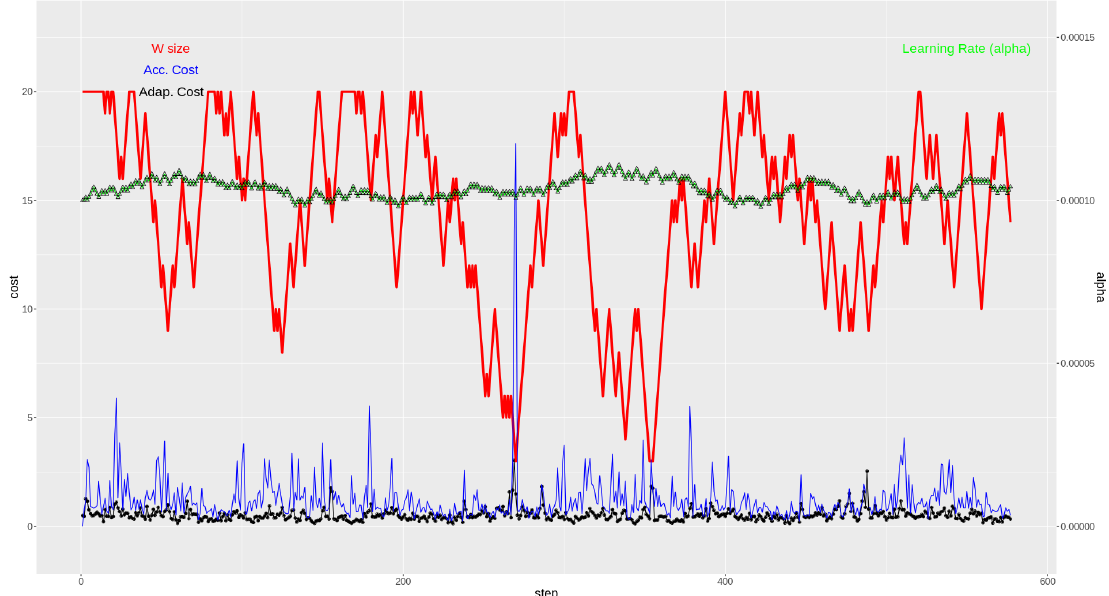
Figure 8. Weather station ID C457I: Worst performance case for the adaptive method. In the lower part, cost (MSE, (m/s) 2 ) obtained with the adaptive strategy (black) and with the accumulative strategy (blue). In the upper part, window size (red) and learning rate (green), both for the adaptive